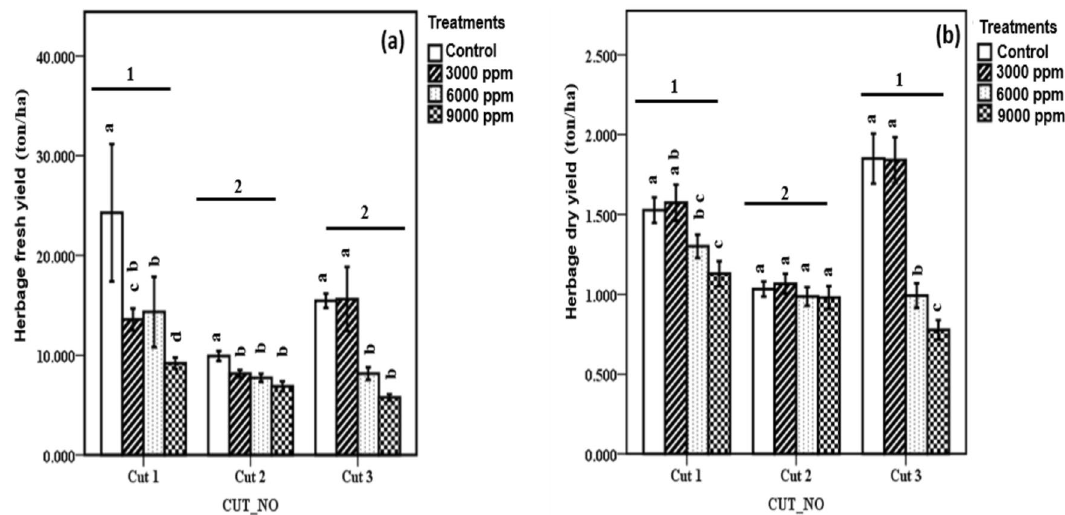
Figure 2. ( a ) Herbage fresh yield and ( b ) herbage dry yield of kale cultivated under fresh water (control) and different salinities (3000 ppm, 6000 ppm, and 9000 ppm) at different cutting time points. Data expressed as mean ± SE. Error bars represent the standard error. Bar columns within the same cutting time point having different letters are significantly different ( p < 0.05). Horizontal bars at the top of bar columns having different numbers indicate a significant difference between cutting time points ( p < 0.05).